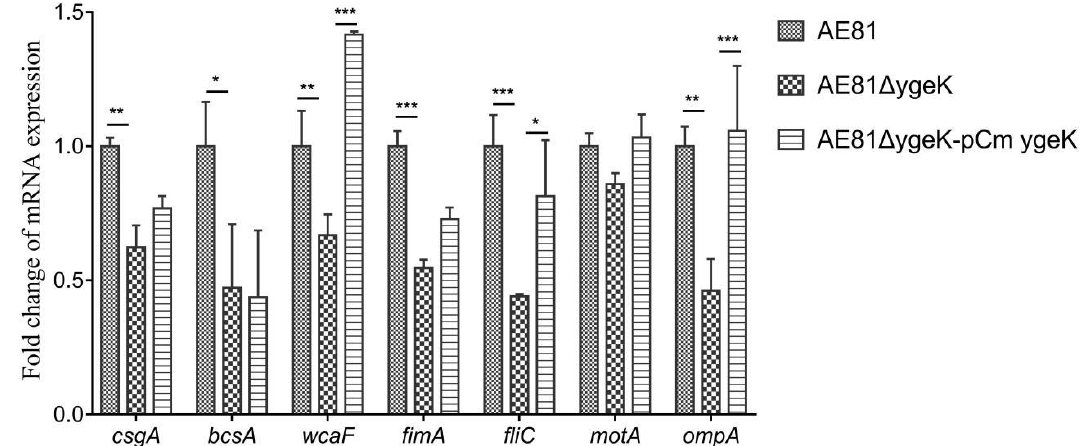
Figure 7. Comparative gene transcription levels (cDNA abundance). Transcript levels of biofilm genes csgA , bcsA , and wcaF , flagellar genes fliC and motA , fimbrial gene fimA , and virulence gene ompA in AE81, AE81 ∆ ygeK , and AE81 ∆ ygeK -pCm ygeK detected by real-time PCR. Results shown as expression ratios relative to expression in wild-type strain AE81. Error bars indicate standard deviation. Statistical significance assessed using two-way ANOVA (* p < 0.05; ** p < 0.01; *** p < 0.001).